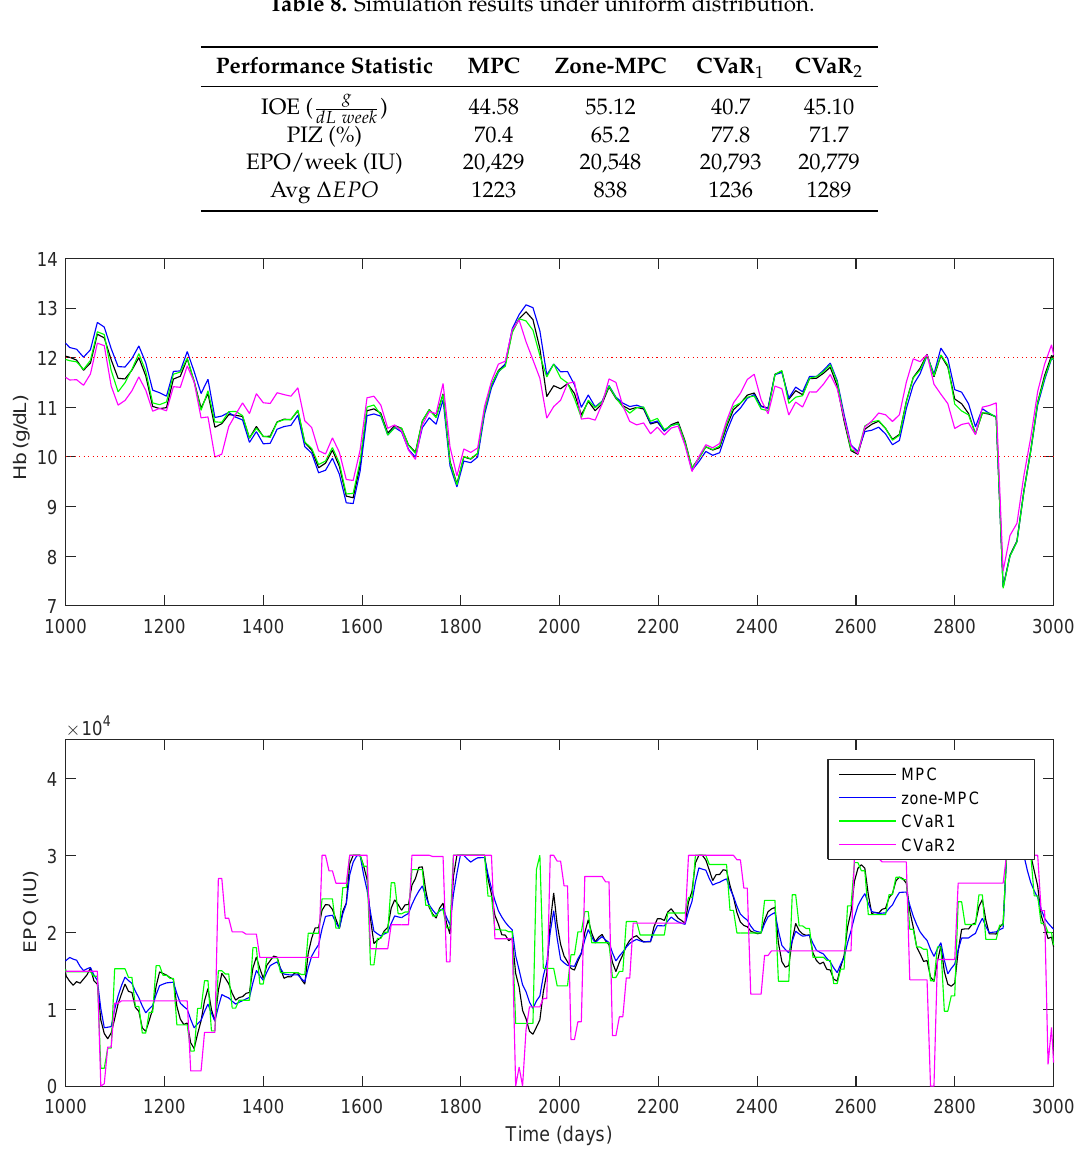
Table 8. Simulation results under uniform distribution.